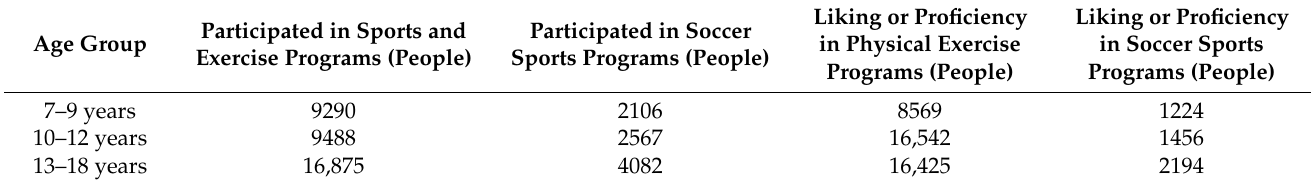
Table 1. Number of participants in each survey program and the number of people who participated in and liked or were proficient in soccer.